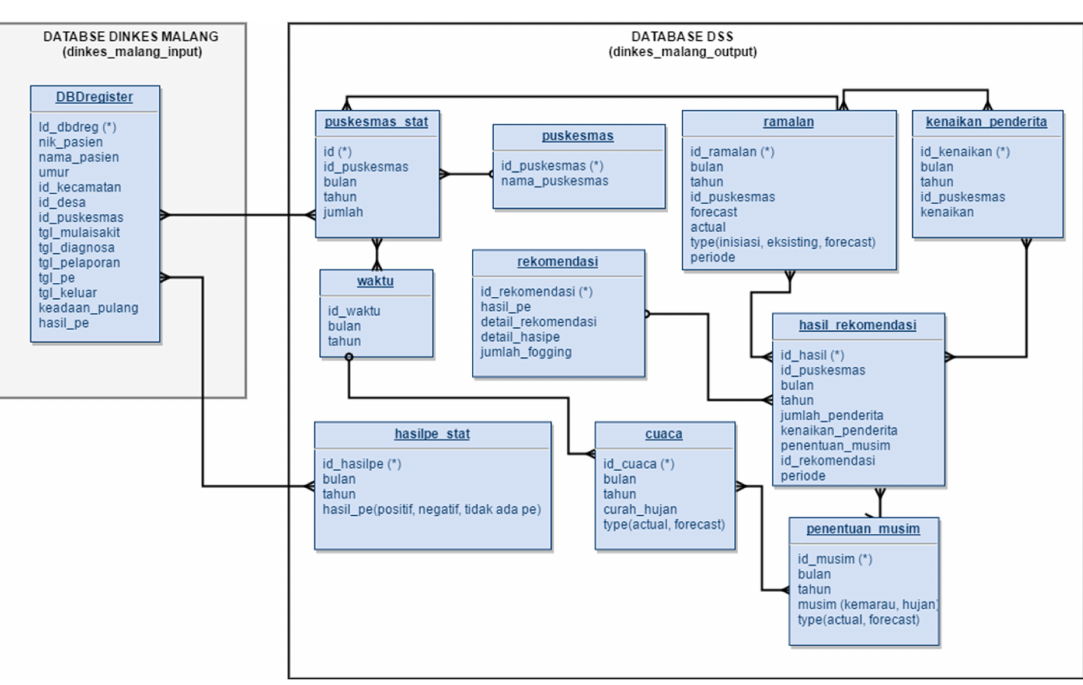
Fig. 4 Database Relation of Malang Health Office